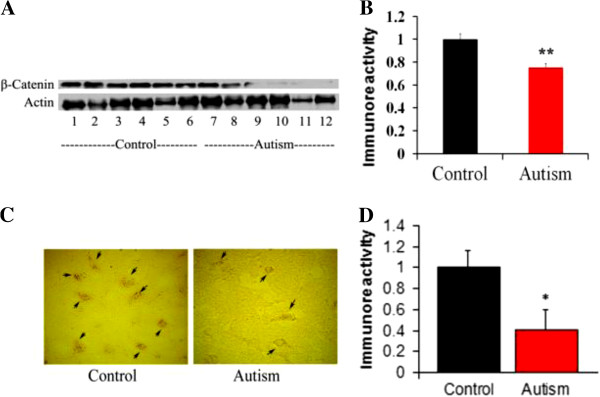
Wnt and β-catenin protein expression in the brain of autistic subjects. Upper panel: western blot analyses were carried out on frontal cortex homogenates from six autistic subjects and six age- and sex-matched controls using an anti-β-catenin antibody (dilution 1:1000) (5A). The blots were quantified after being normalized by actin (5B). Data are shown as mean ± standard error (SE). **P < 0.01. Lower panel: immunohistochemistry studies were carried out on frontal cortex sections from six autistic subjects and six age-matched controls using an anti-Wnt antibody (dilution 1:100). Weaker immunostaining of Wnt protein (dark brown color as indicated by arrows) was present in the autistic subjects compared with the controls (5C). Immunostaining density was quantified using Image J analysis (5D). Data are shown as mean ± standard error (SE). *P < 0.05. Scale bar: 20 μm.